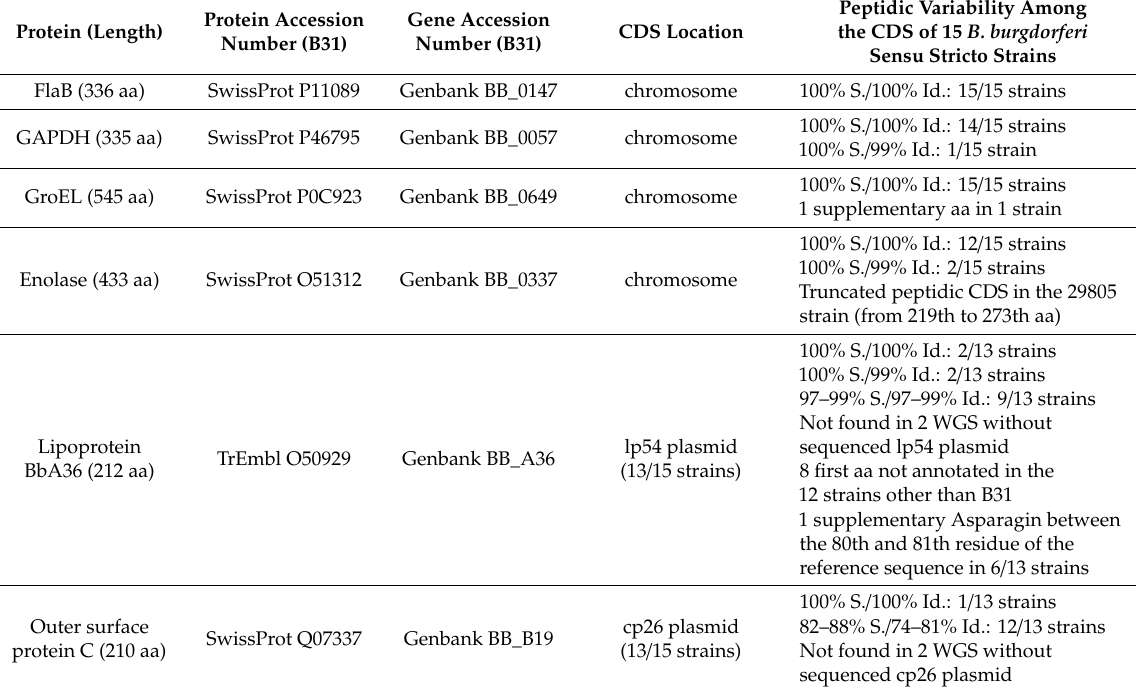
Table 3. Peptide variability of six protein-coding sequences in the species B. burgdorferi sensu stricto. The 15 B. burgdorferi sensu stricto strains studied were B31, CA382, 64b, ZS7, BOL26, WI91-23,